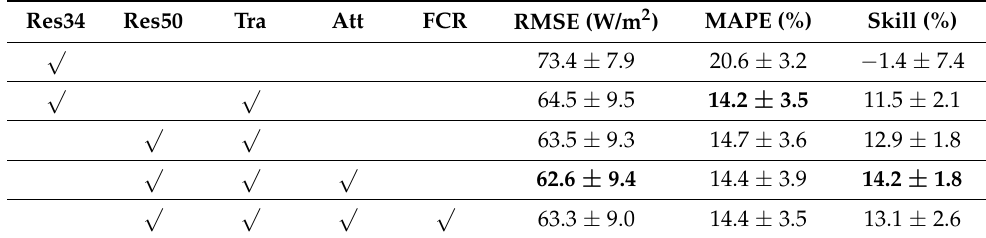
fully connected layer